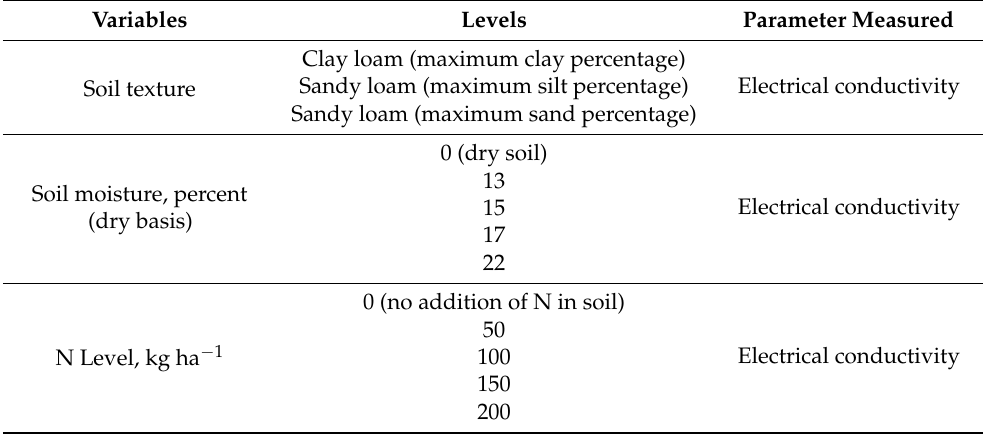
Table 1. Plan of experiment for determining relationships between EC, soil moisture, and N level of